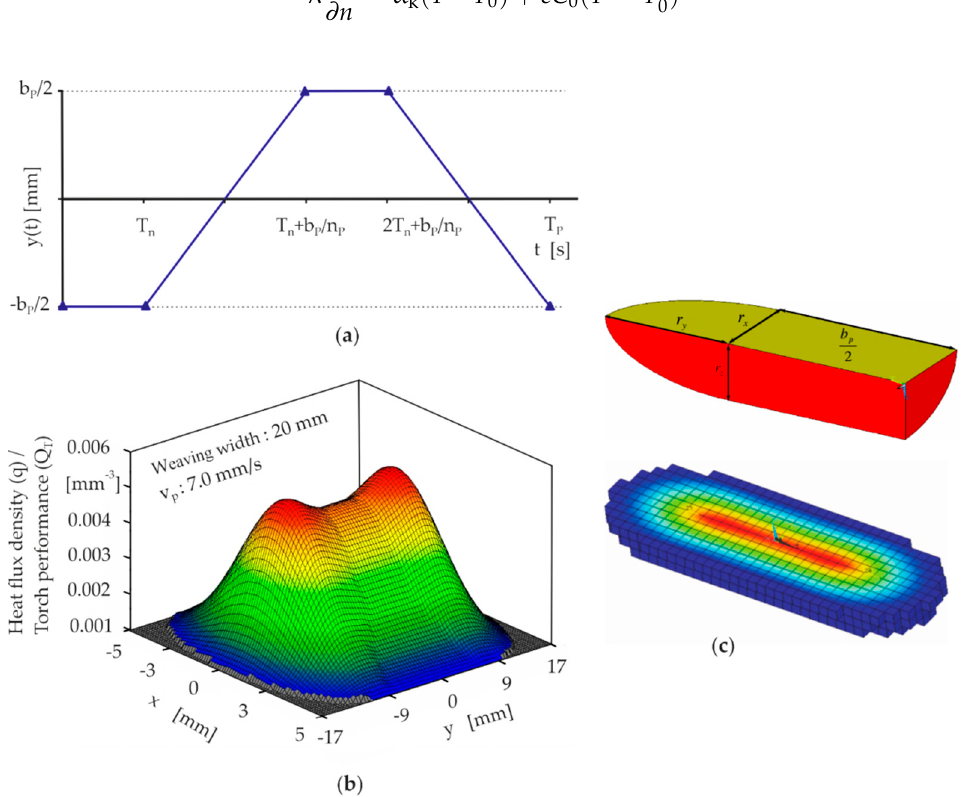
Figure 2. Heat source model—3DPMD with an ellipsoid PMD heat source: ( a ) finite element (FE)—heat source model; ( b ) Weaving thermal deposition and ( c ) deposited material volume produced by the heat source.